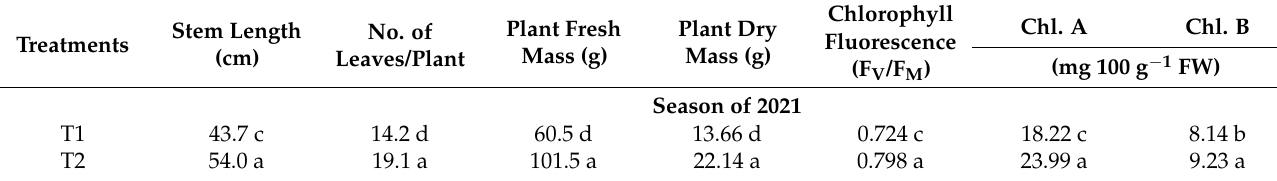
Table 5. Vegetative growth traits, chlorophyll fluorescence, and chlorophyll content of common bean plants influenced by the treatments in the field experiments and where T1 = negative